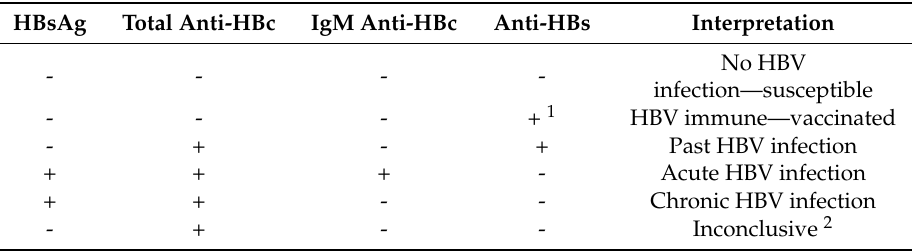
Table 1. Hepatitis B Virus (HBV) serology